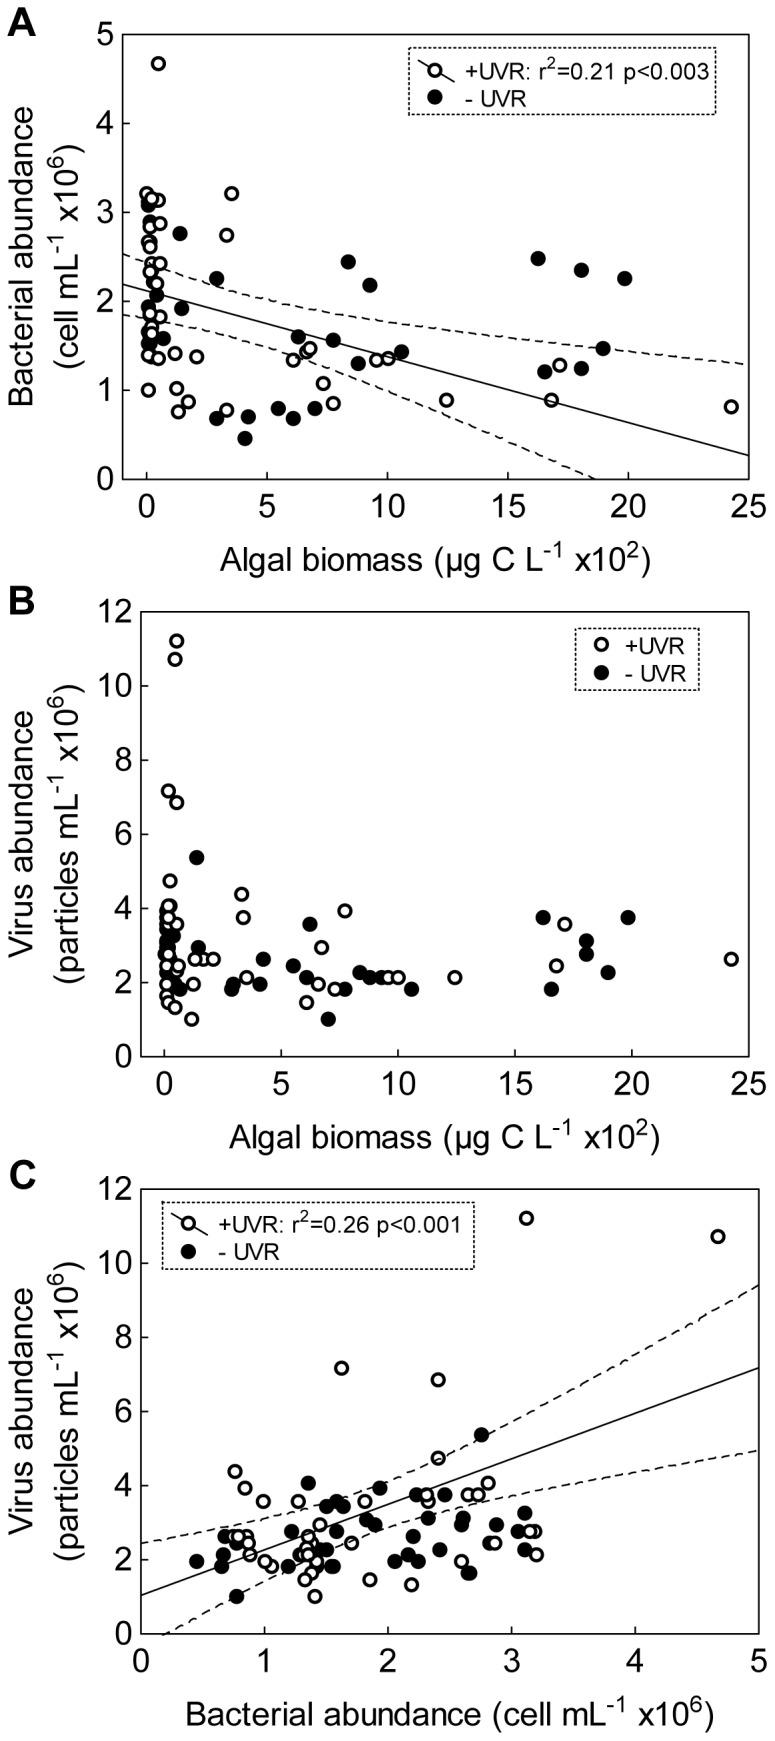
Relationships between compartments.(A) Bacterial abundance vs. algal biomass; (B) virus abundance vs. algal biomass; (C) virus abundance vs. bacterial abundance. Dashed lines indicate 95% interval confidence for each regression when significant.